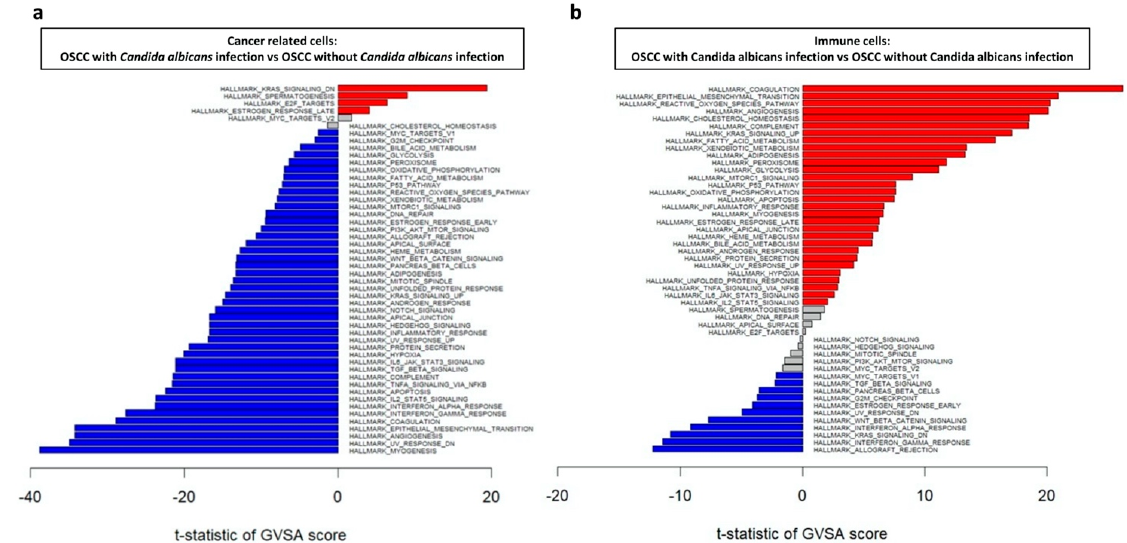
Figure 5. GSVA of regulatory pathways in ( a ) cancer-related cells and ( b ) immune cells in OSCC tissue with and without Candida albicans infection. Red and blue bars indicate that gene expression was significantly increased in OSCC tissue with C. albicans infection compared with that without C. albicans infection and OSCC tissue without C. albicans infection compared with that with C. albicans infection, respectively (both p < 0.05).